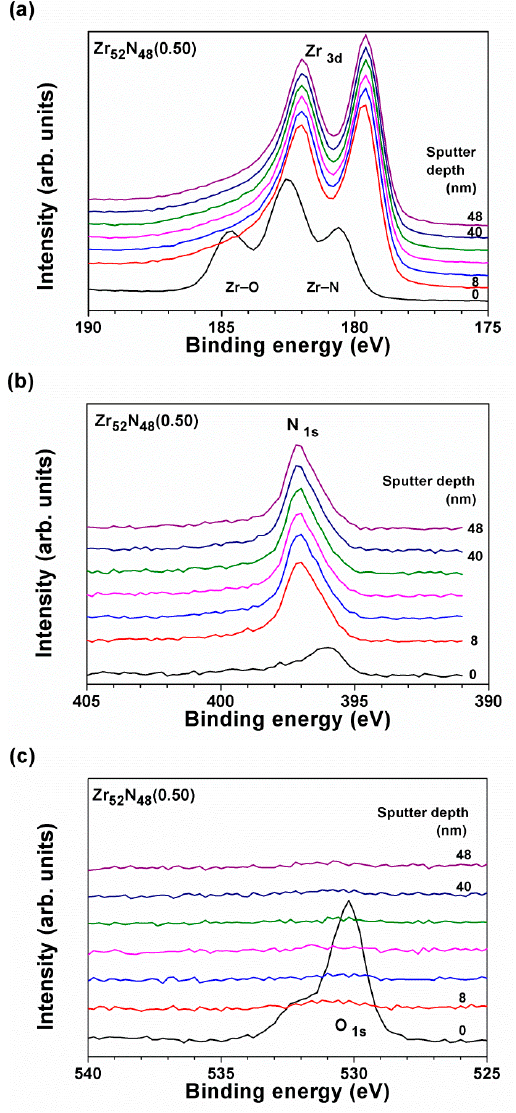
Figure 5. X-ray photoelectron spectroscope (XPS) profiles of the ( a ) Zr 3 d , ( b ) N 1 s , and ( c ) O 1 s core levels of the Zr 52 N 48 (0.50) films at depths of 0 to 48 nm (sputter rate = 8 nm/min for SiO 2 ).